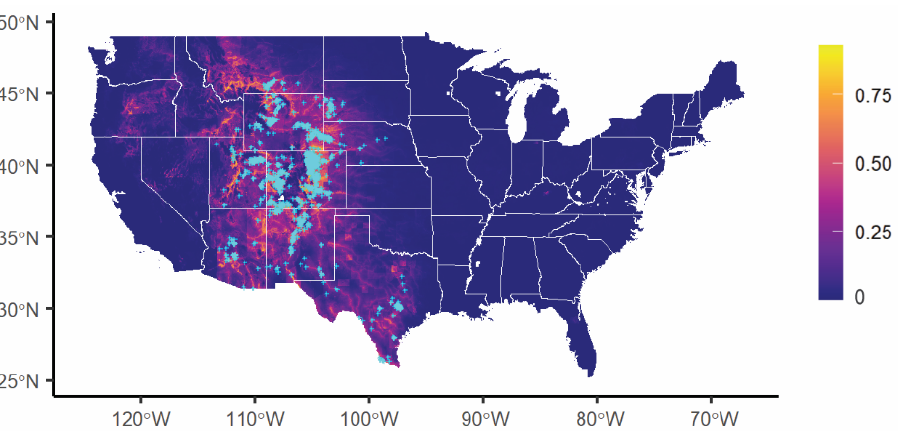
Figure 3. Estimated relative occurrence rates (ROR) for Vesicular Stomatitis (VS) using long-term mean current climate and other environmental factors shown in Table 1. Recorded incidences of VS from 2004 through 2016 that were used as presence data in this analysis are shown as cyan ‘+’.